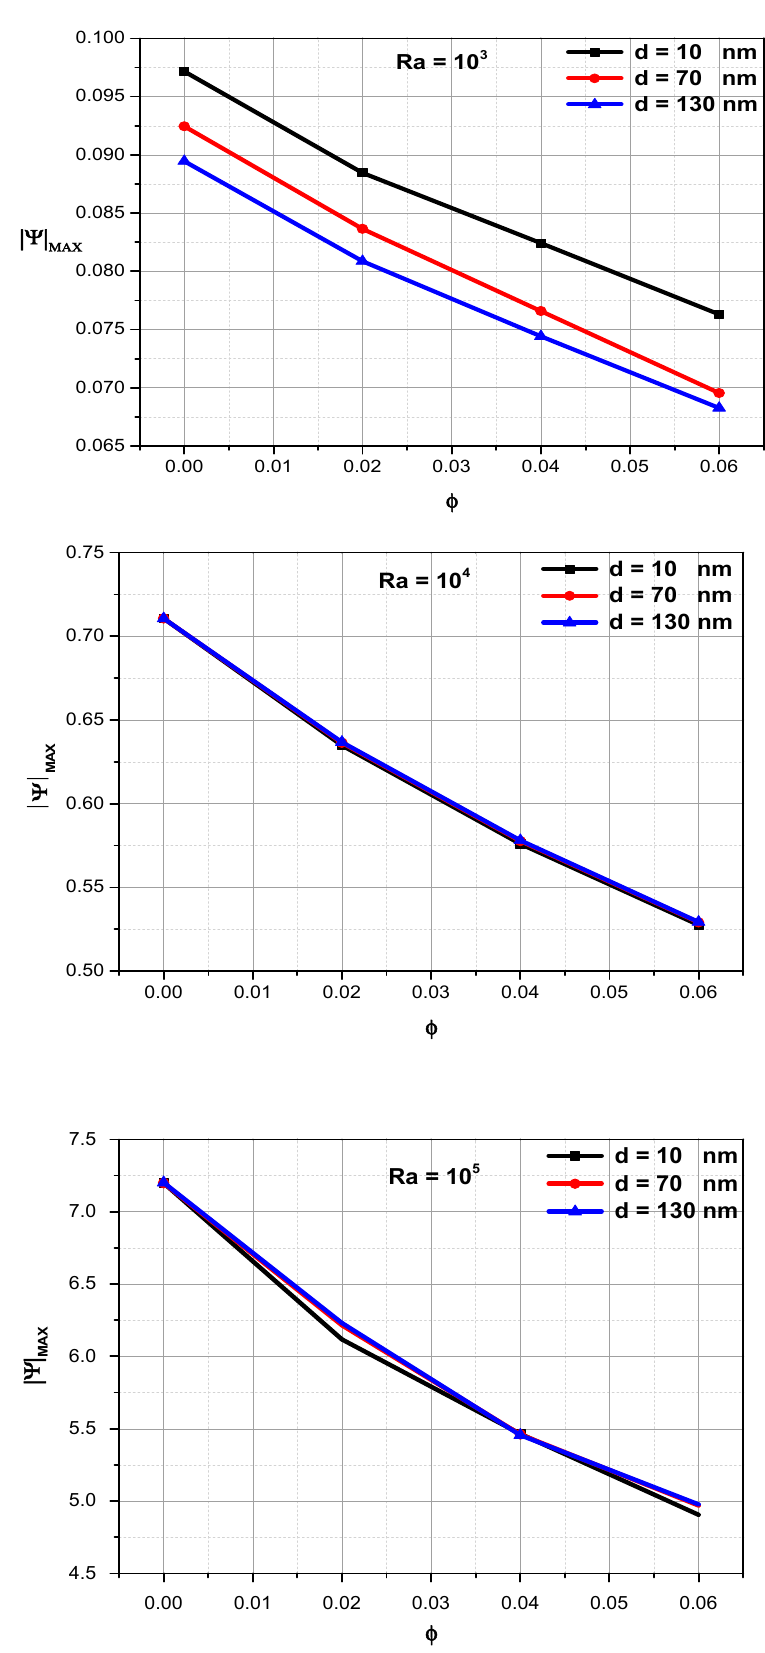
Figure 10. Variation of the temperature profiles on the Y-axis for different Rayleigh numbers and